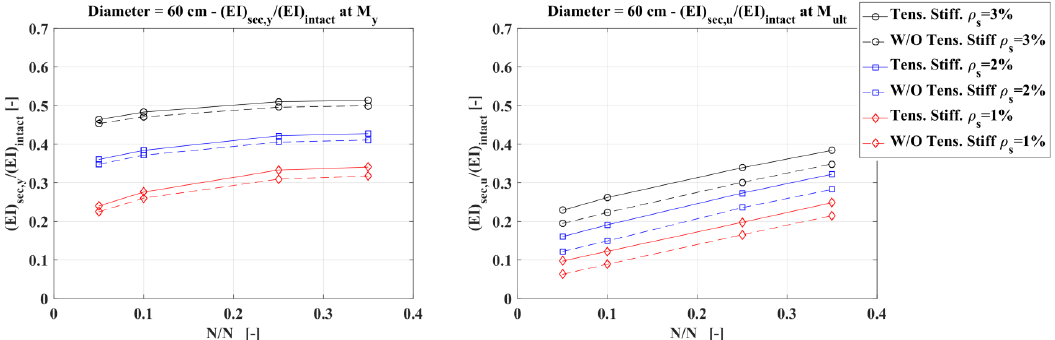
Figure 13. Diameter 60 cm: normalized secant stiffness at first steel bar yielding ( left ) and at peak stress in compression ( right ).